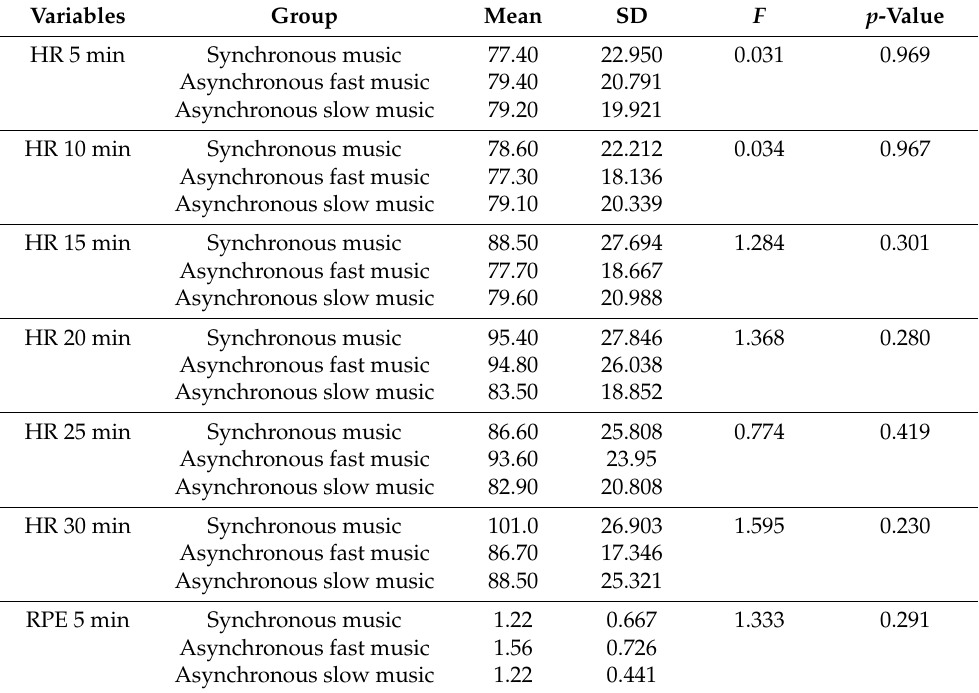
Table 7. Table synchronous, asynchronous music for variables differences. Variables